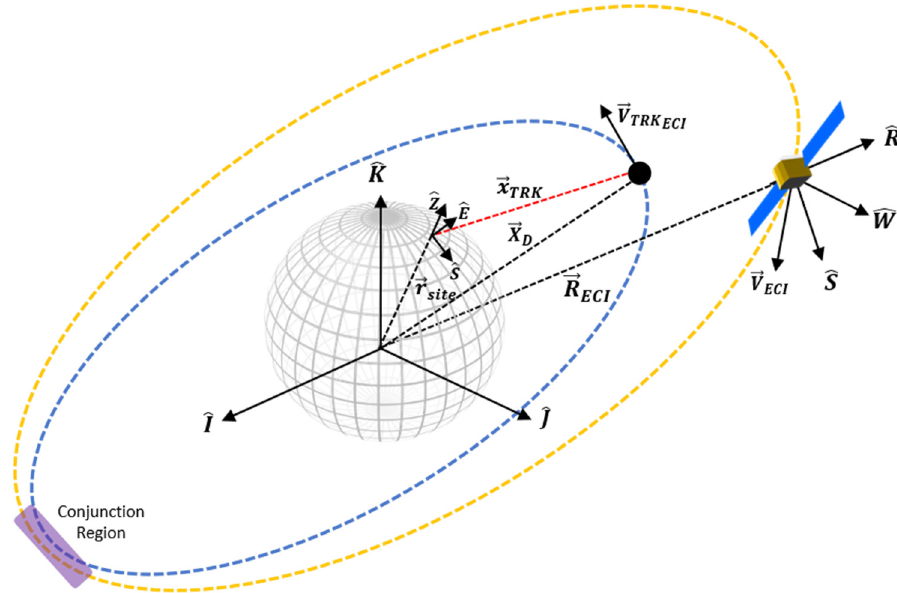
Figure 3. Illustration of ground-based tracking scenario and subsequent conjunction region with operational satellite.